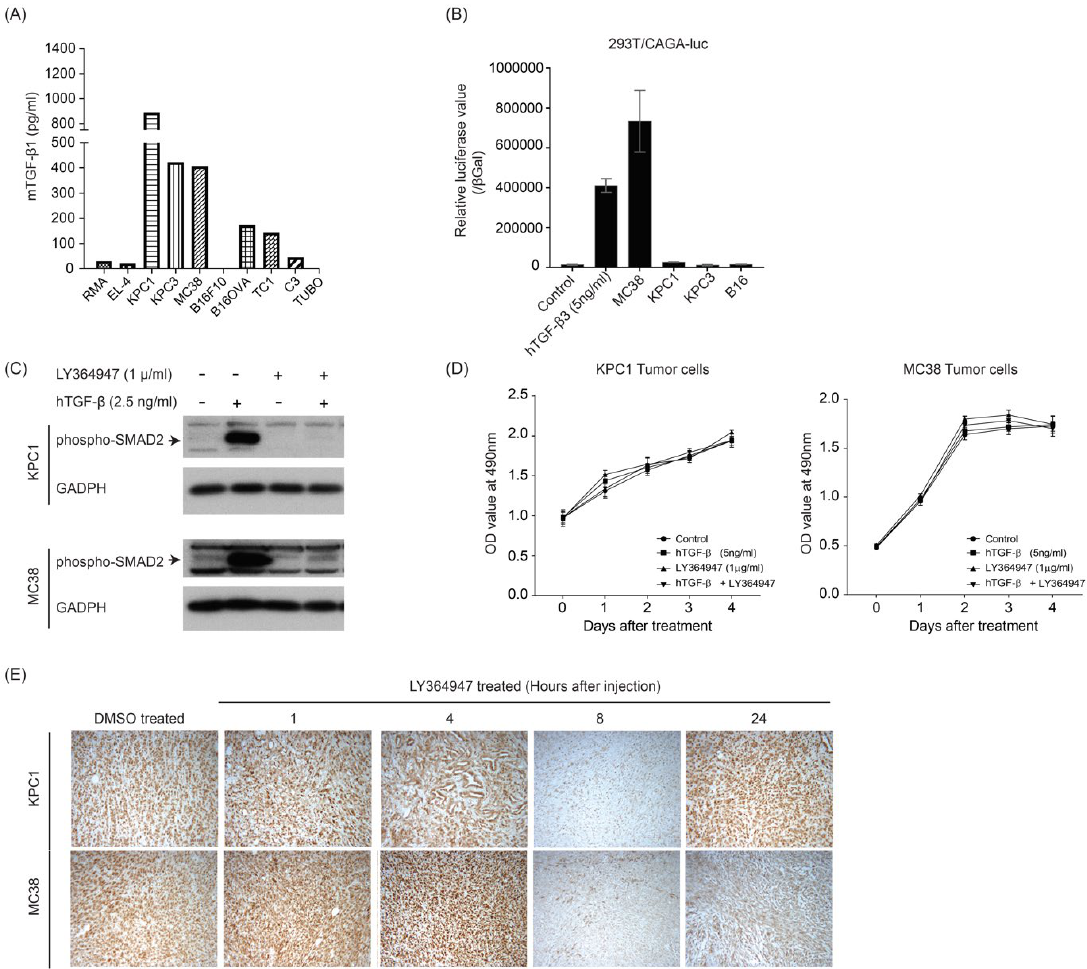
Figure 1. Production level of transforming growth factor- β (TGF- β ) by various preclinical mouse tumor models and the potency of LY364947 to inhibit TGF- β -mediated cellular SMAD2 phosphorylation. Latent ( A ) and active ( B ) TGF- β in the conditioned media of cancer cell lines was assessed by TGF- β 1 ELISA and transcriptional CAGA-luciferase reporter assay, respectively. ( C ) Immunoblotting of phospho-Smad2 of KPC1 and MC38 tumor cell lines after TGF- β and/or LY364947